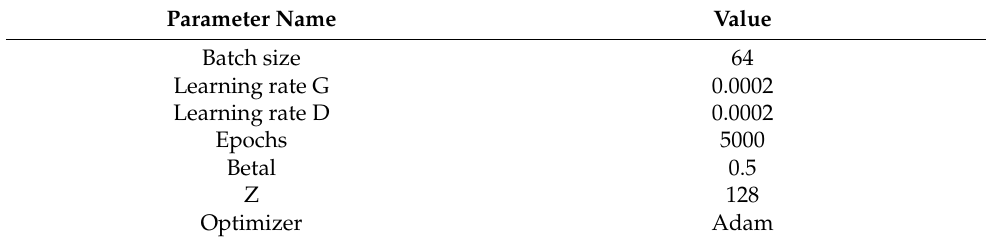
Table 1. The parameters of